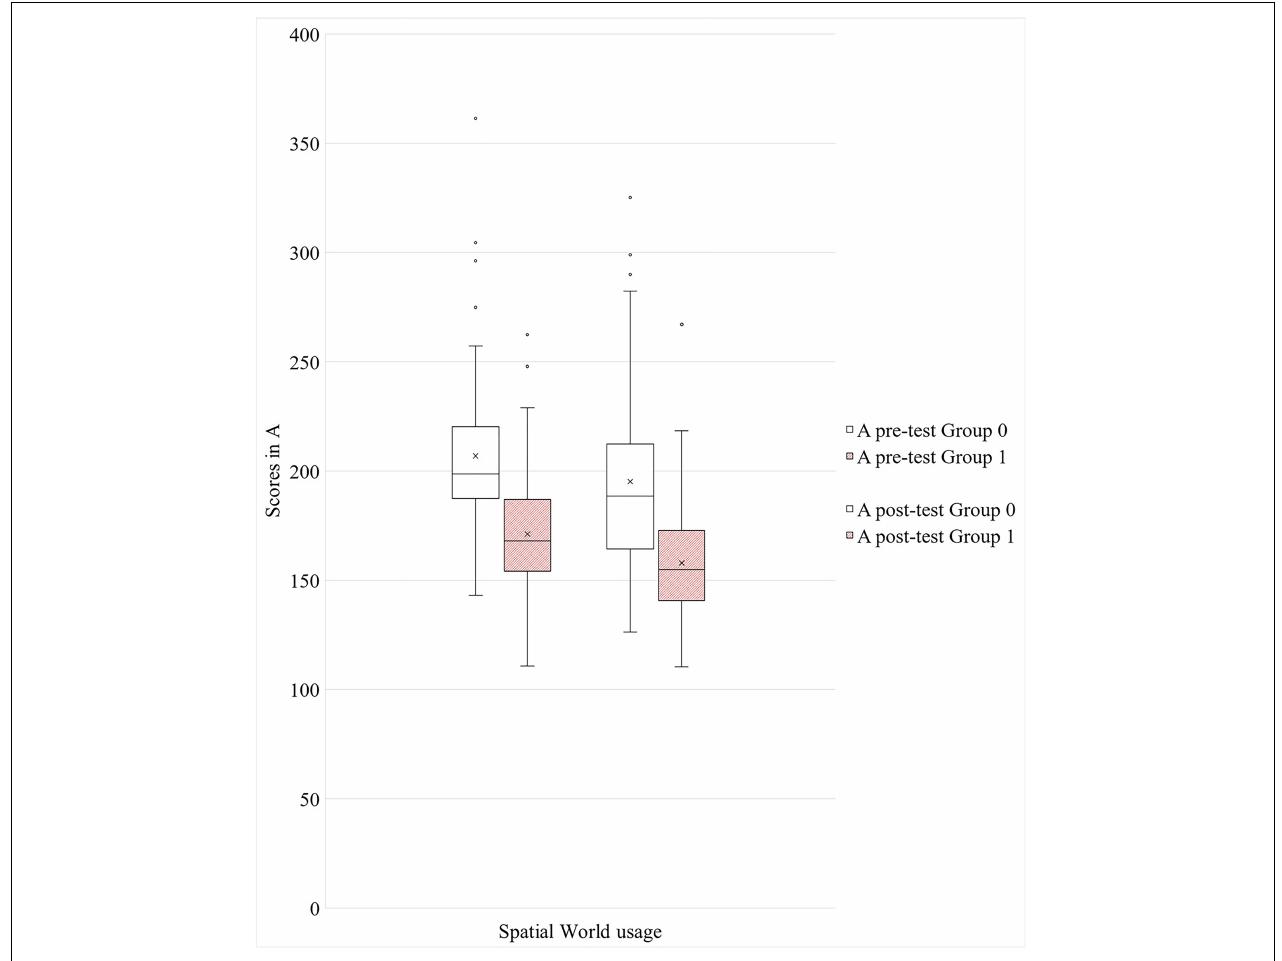
FIGURE 8 | Graphics of the differences between group 0 (less use) and group 1 (more use) showing scores obtained from A with the use of Spatial activities. Scores at task A are measured in time, being thus inverse to